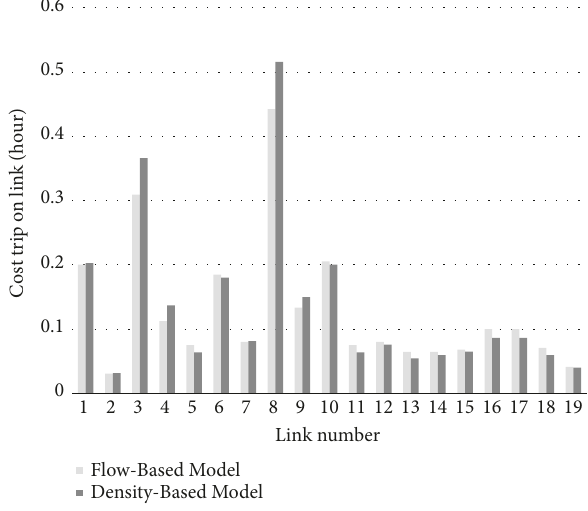
Figure 6: Link Costs, Both Approaches (high